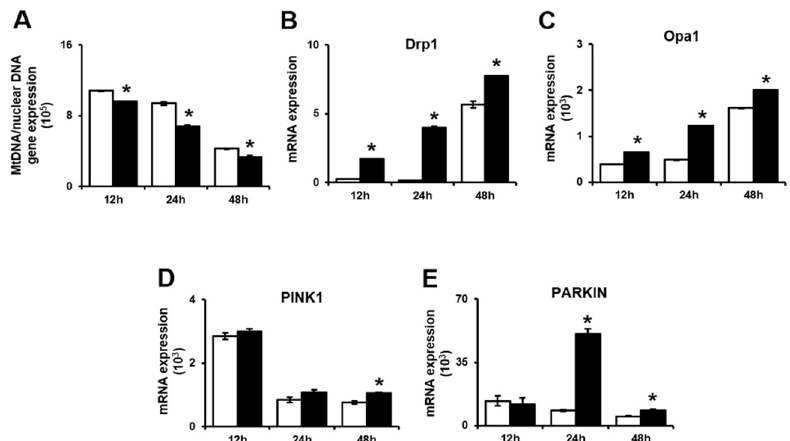
Figure 5. PD-MSCs trigger mitochondrial autophagy in invasive trophoblasts via altering the balance between PINK1 and PARKIN expression. ( A ) The ratio of mitochondrial DNA in gDNA analyzed by qRT-PCR. The mRNA expression of ( B ) Drp1 and ( C ) Opa1 in invasive trophoblast cells with and without PD-MSC cocultivation over time. The mRNA expression of ( D ) PINK1 and ( E ) PARKIN in invasive trophoblast cells with and without PD-MSC cocultivation over time. The data were performed in at least triplicate and expressed as the means ± S.D. Indicates * p < 0.05. White bar: control, Black bar: PD-MSC cocultivation. *: control vs. PD-MSC cocultivation at each time point. PD-MSCs: Placenta-derived mesenchymal stem cells; PINK1: PTEN-induced kinase 1; PARKIN: parkin RBR E3 ubiquitin protein ligase; gDNA: Genomic deoxyribonucleic acid; qRT-PCR: Quantitative reverse transcription polymerase chain reaction; mRNA: messenger RNA; Drp1: Dynamin-1-like protein; Opa1: OPA1 mitochondrial dynamin like GTPase.